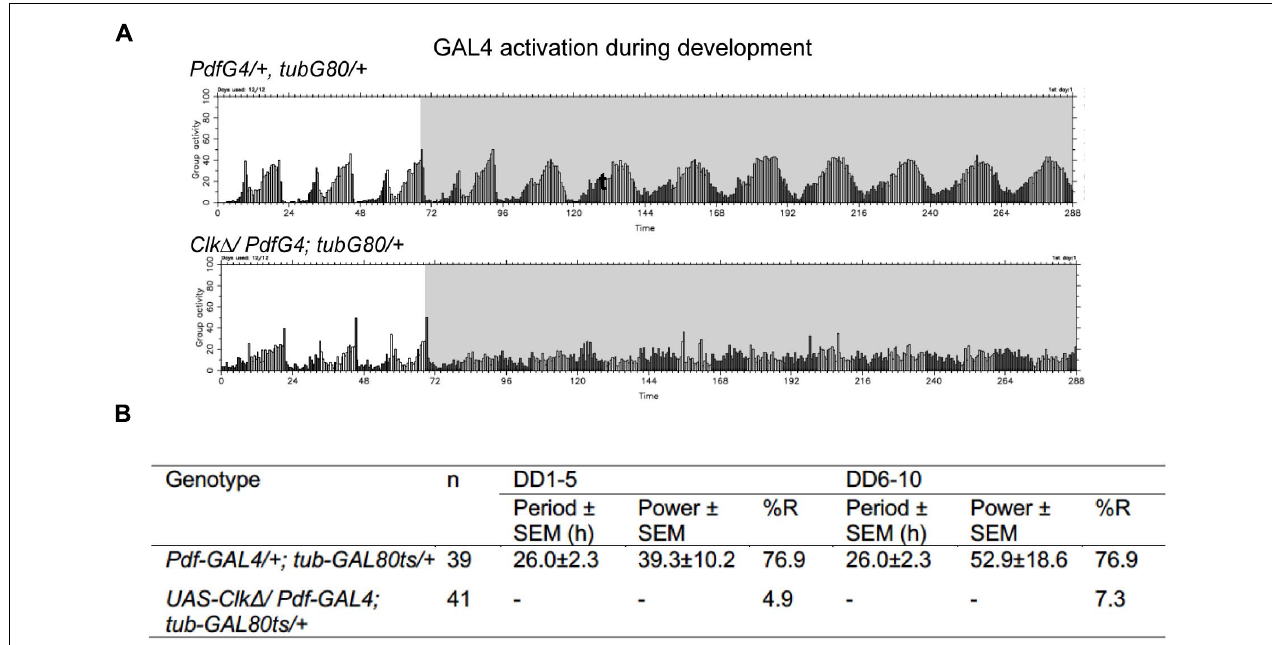
FIGURE 4 | CLK (cid:49) expression during development in the M-cells irreversibly disrupts locomotor rhythms in adulthood. (A,B) UAS-Clk (cid:49) was expressed with Pdf-GAL4 , tub-GAL80 ts only during development. (A) Group average locomotor rhythms assayed at 18 ◦ C following the developmental CLK (cid:49) expression. (B) Percentage of rhythmic flies in DD1-5 and DD6-10 in the flies following developmental CLK (cid:49) expression and